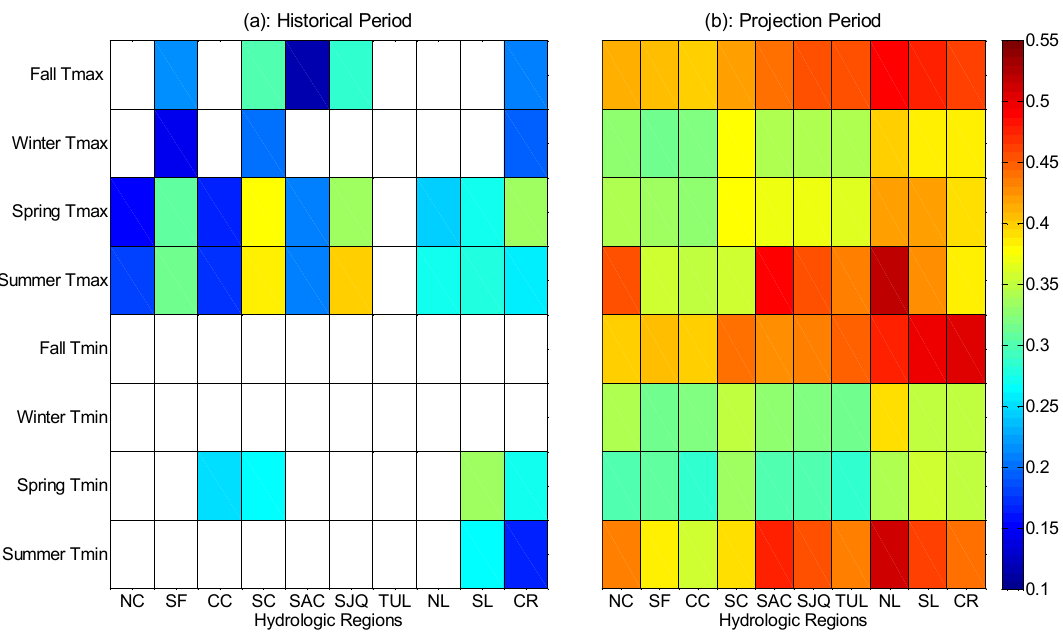
Figure 10. Trend slopes of ( a ) historical (1951–2013) and ( b ) projected (2020–2099) mean seasonal maximum temperature (Tmax) and minimum temperature (Tmin) (at significance level 0.05). Different colors mean different trend slopes (per decade). White color indicates no significant trends.